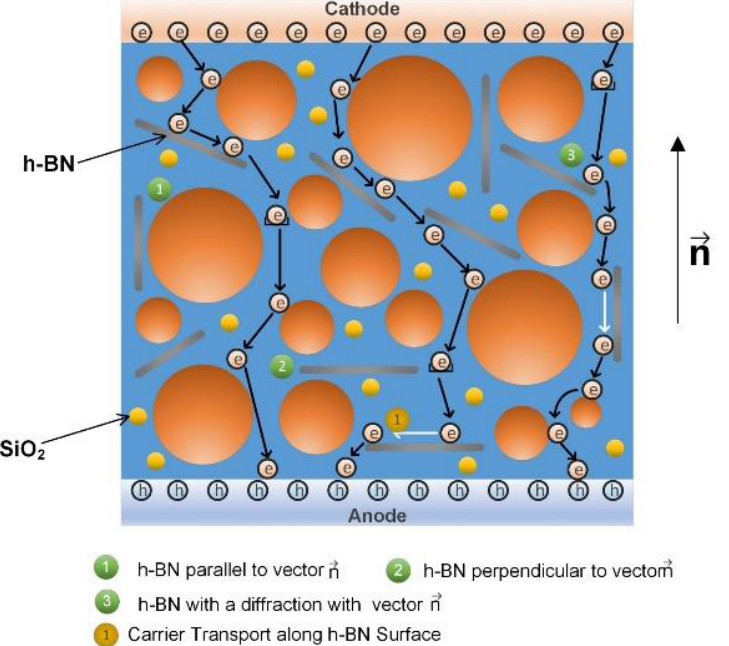
Figure 2. Scheme of various filler orientations and possible charge transport mechanism within the polyethylene micro/nano-composite. Table 1. The values of the parameters used in BCT simulation [35 – 39].